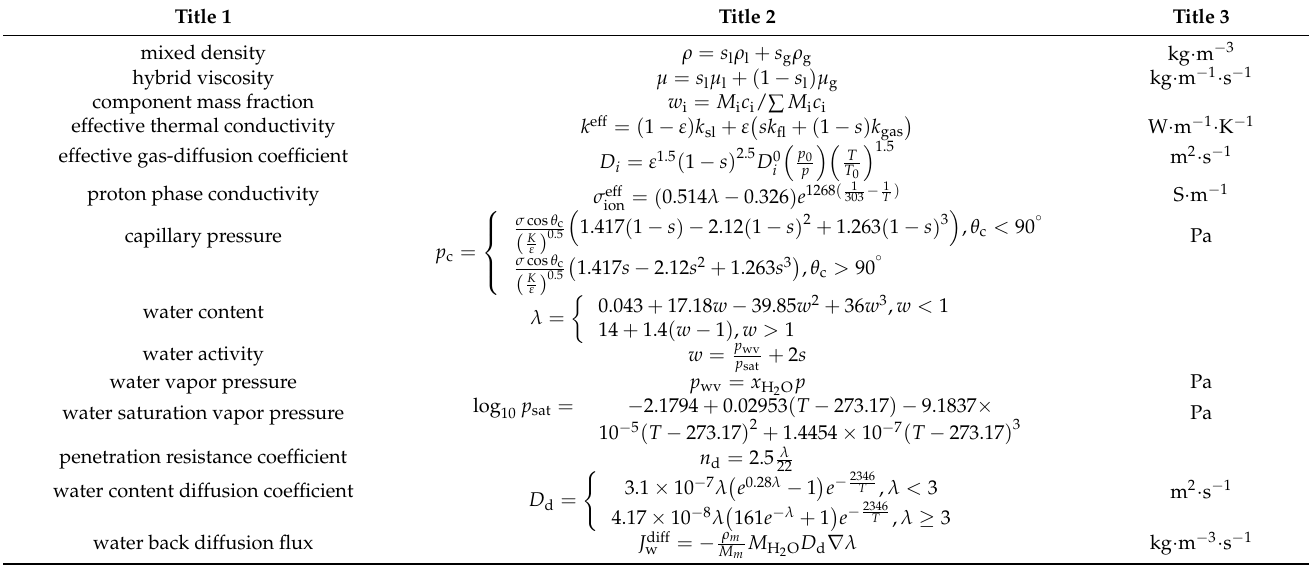
Table 4. Parameter definitions and physical property